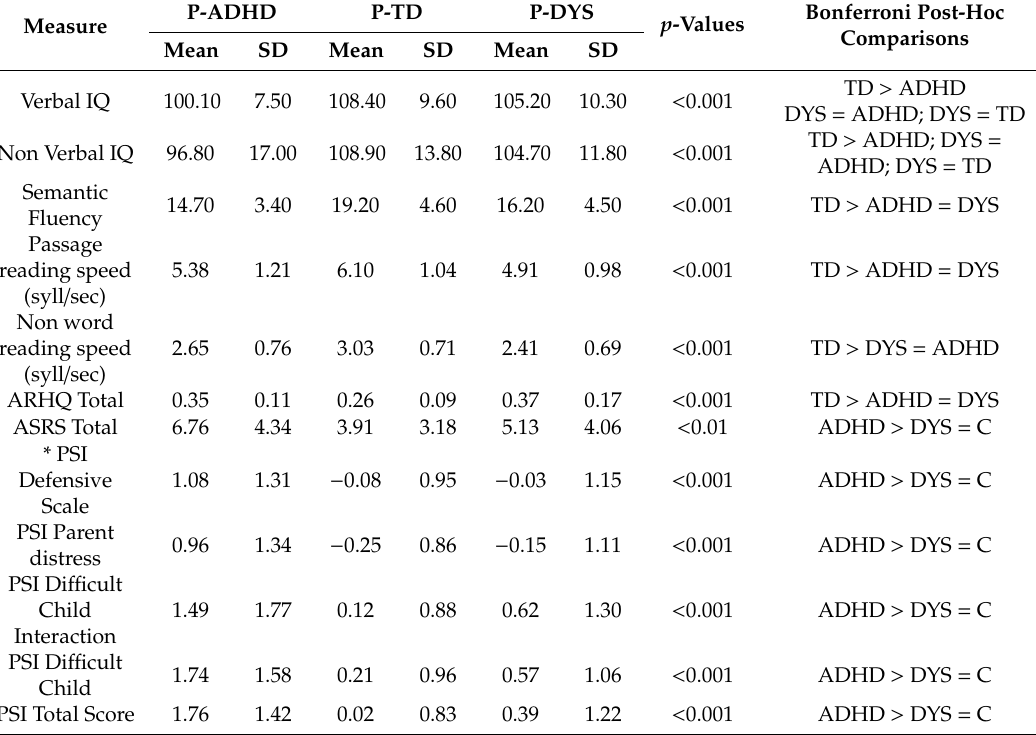
Table 2. Means and standard deviations for cognitive tasks and questionnaires’ scores for the three groups (P-ADHD, P-TD,